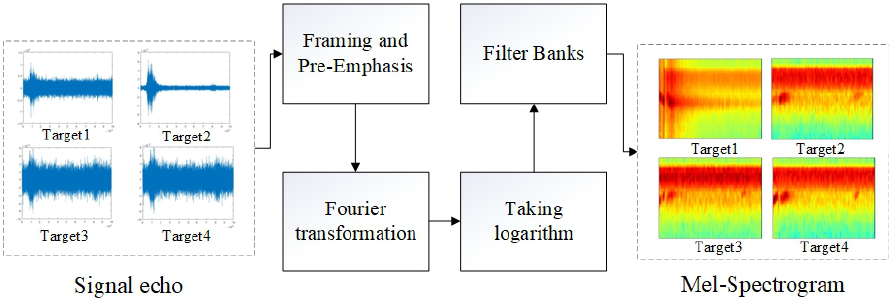
Figure 2. Mel-spectrogram extraction flow